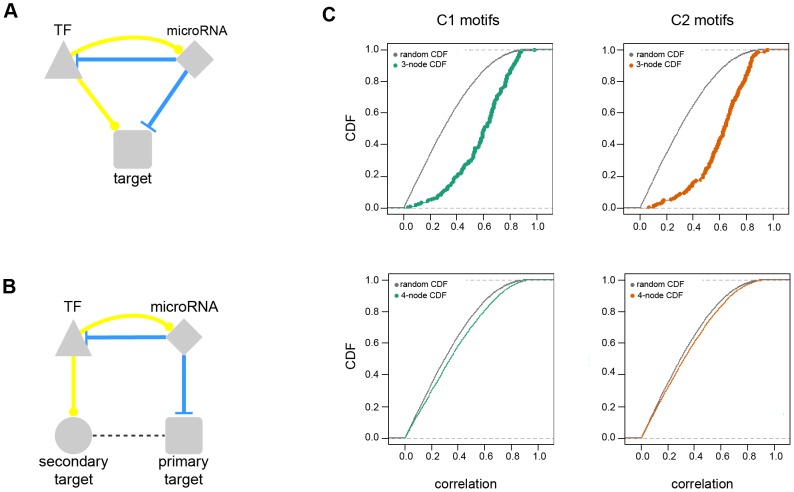
MicroRNA and TF co-regulatory motifs.Schematic illustration of (A) 3-node and (B) 4-node FFL motifs. A 3-node motif contains a microRNA, a TF, and a commonly regulated target gene. In contrast, 4-node FFLs comprise a microRNA, a TF, a microRNA target gene (primary target), and a TF target gene (secondary target) that interacts with the primary target. MicroRNAs are indicated with diamonds, TF with triangles, primary targets with rectangles, and secondary targets with circles. (C) Coexpression of microRNA and TF target genes. The plot shows the observed and random cumulative distribution functions (CDFs, y-axis) of the Pearson correlation coefficients (x-axis) between any gene pair regulated by a specific microRNA and TF 3-node and 4-node motif. The observed and random CDFs are compared using the KS test. The p-values are indicated within the plots. Green and orange color codes correspond to the distinct clusters C1 and C2.